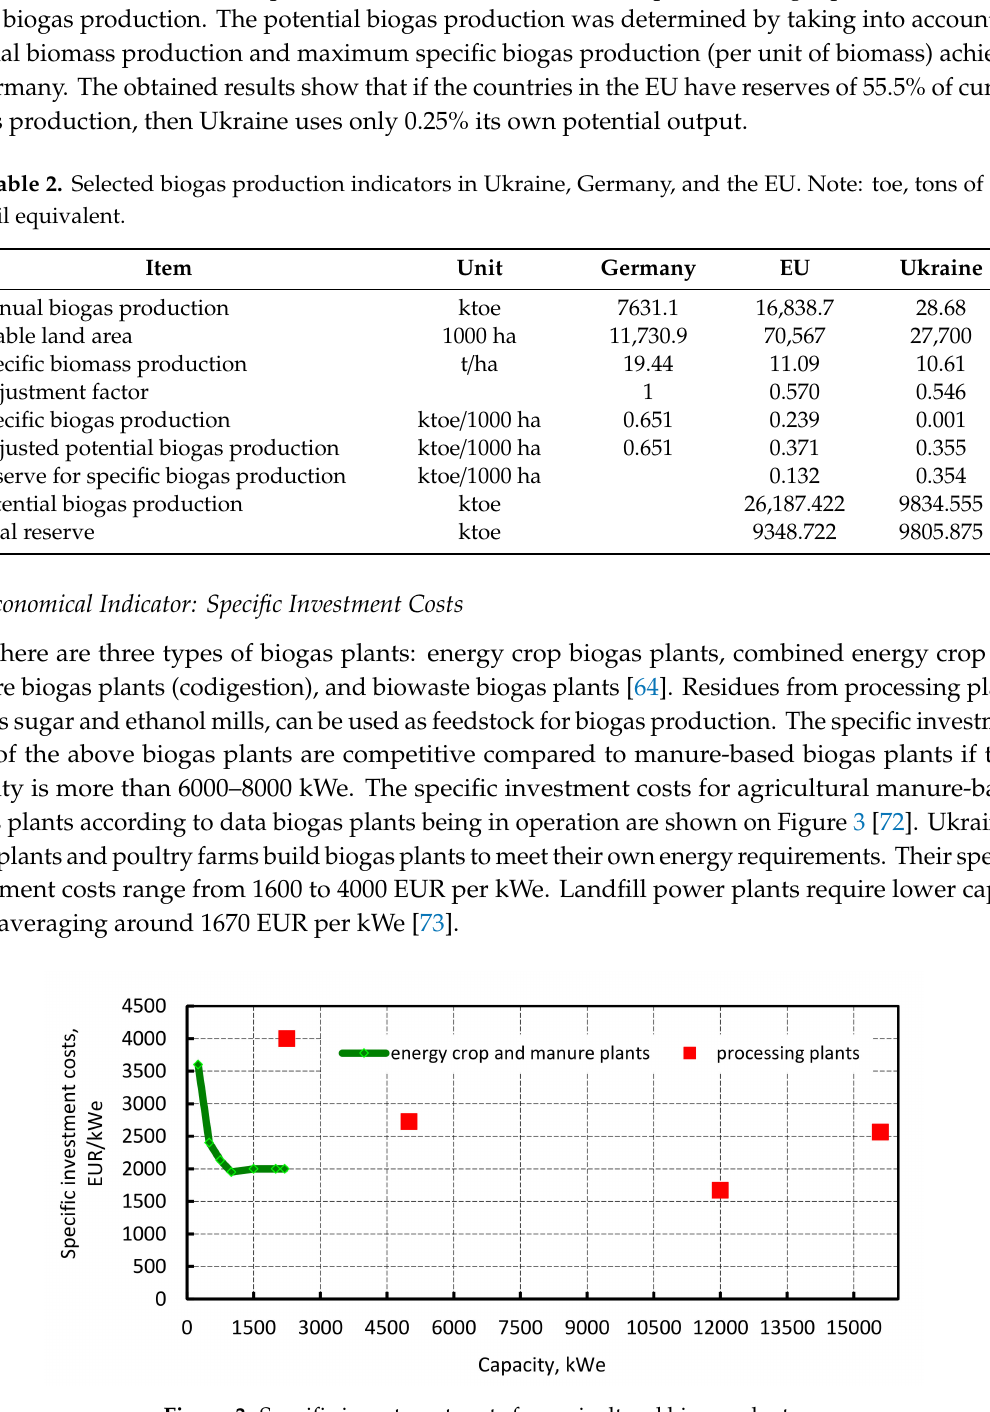
Figure 3. Specific investment costs for agricultural biogas